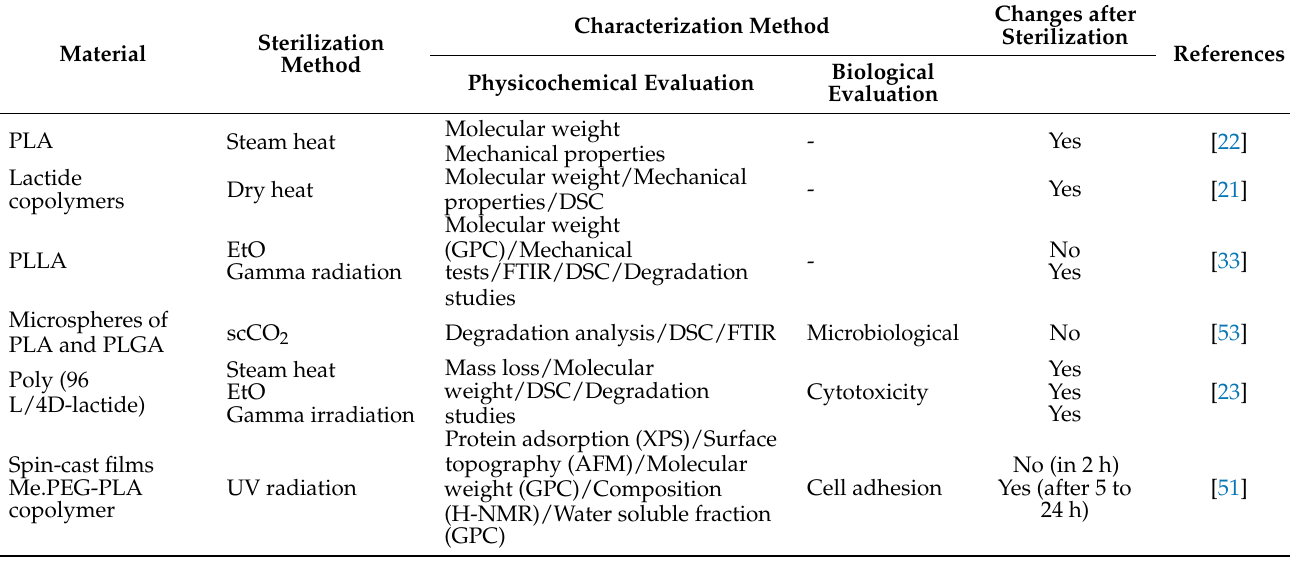
Table 2. Summary of the state-of-the-art since 1990 regarding the sterilization of polylactic acid (PLA) based materials for biomedical